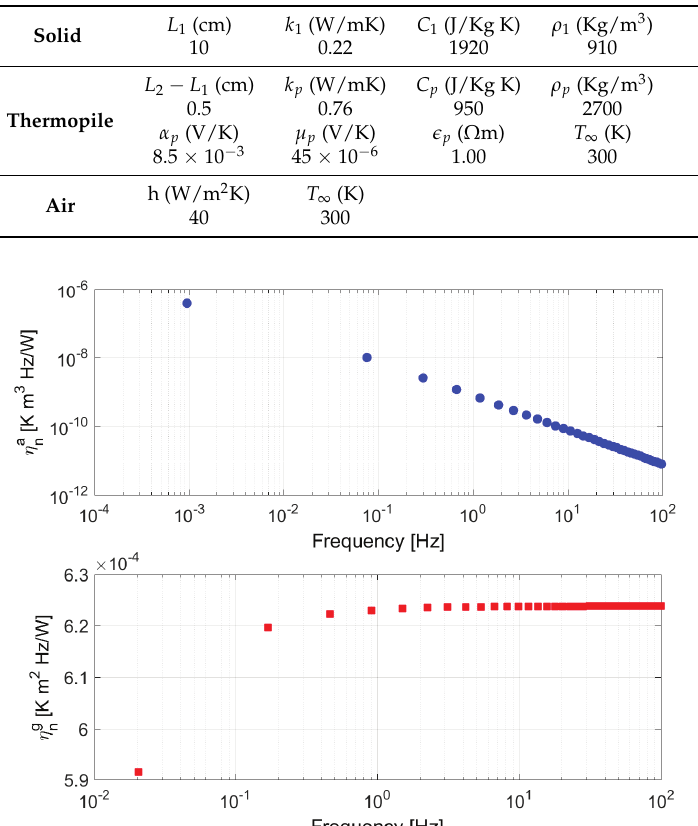
Figure 4. ( Top ) diffusive symbols η a n corresponding to the first 40 pole frequencies ω a n of H a ( Bottom ) same for η g n at ω g n of H g